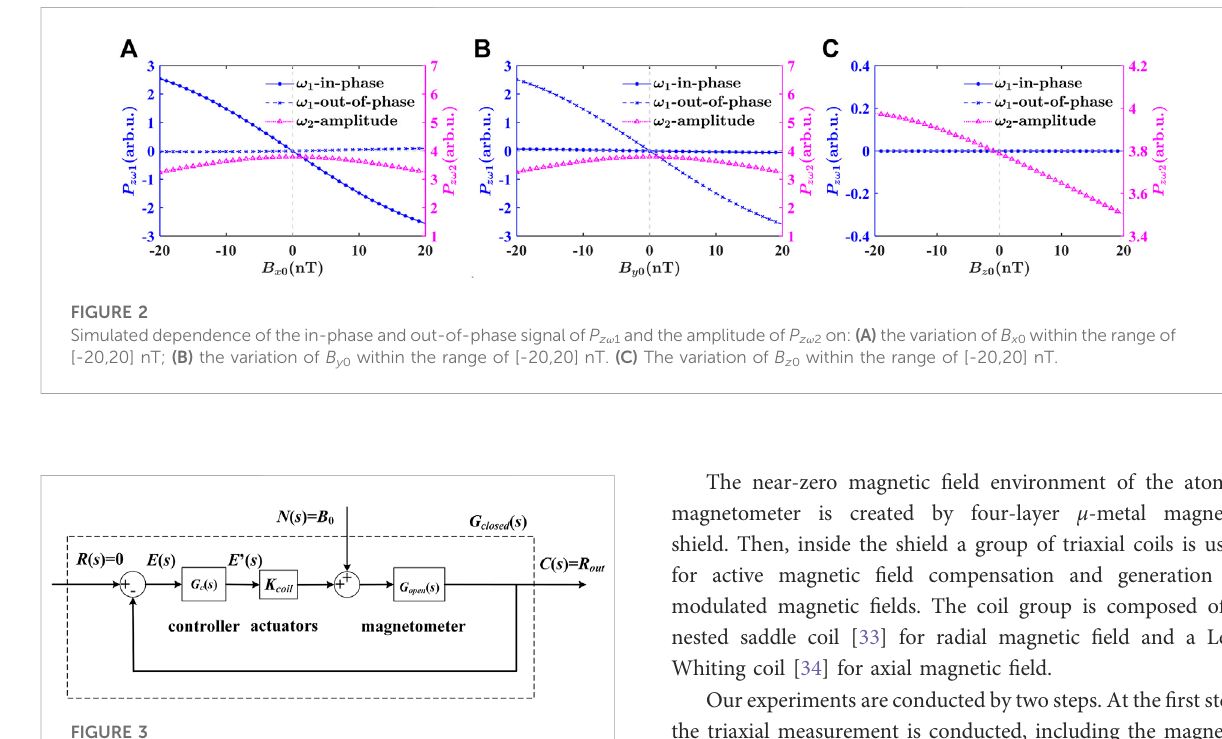
FIGURE 3 The schematic of negative feedback with PI controller and actuators (waveform generator, resistor, and coil) of the closed- loop magnetometer in a single